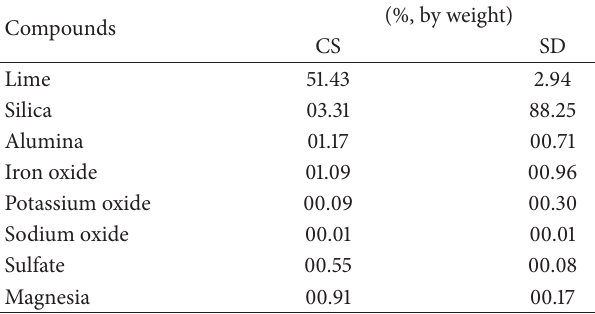
Table 2: Chemical composition of fine aggregates (crushed sand and dune sand) used (%, by